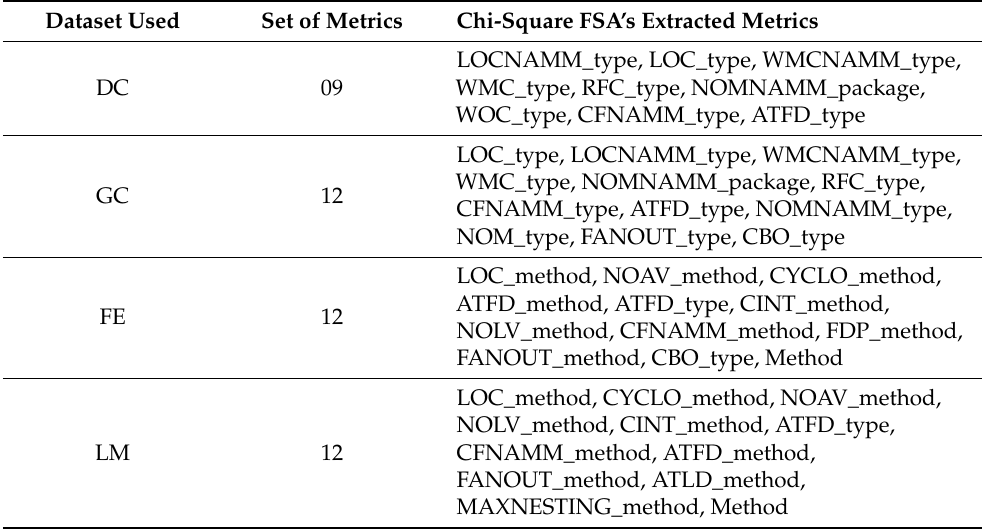
Table 4. Chi-square FSA’s extracted metrics. Dataset Used Set of